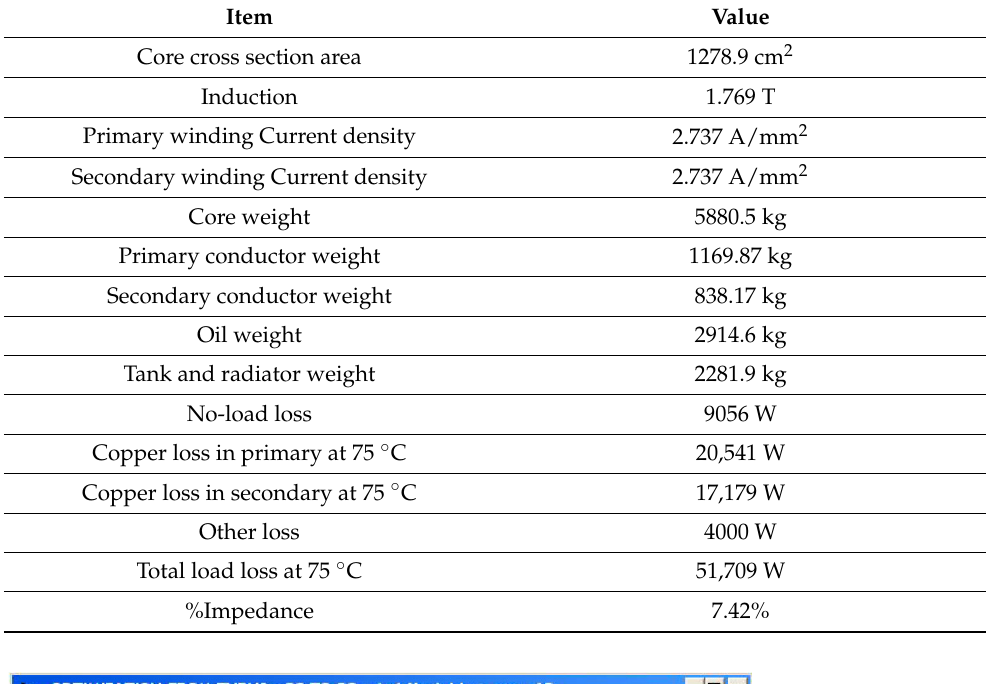
Table 2. Design output.